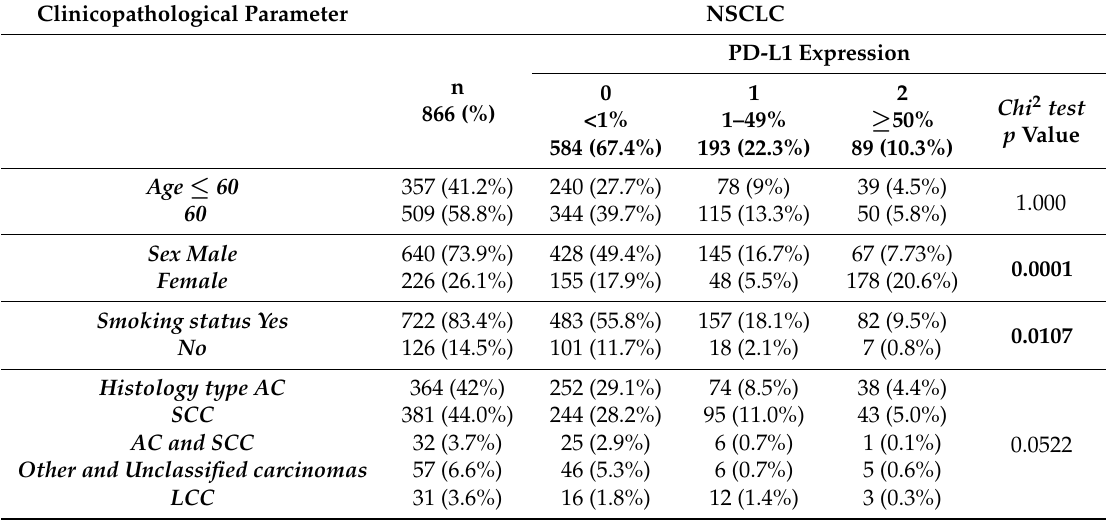
Figure 2. PD-L1 protein expression and CD274 mRNA in non-small cell lung cancer (NSCLC) are higher than in healthy lung tissues. Comparison of PD-L1 protein expression levels detected by immunohistochemistry (IHC) ( A ) in different subtypes of NSCLC (* p = 0.0074). Positive correlation between mRNA expression levels of CD274 detected by the real-time PCR and PD-L1 expression detected by IHC evaluated by Tumor Proportion Score (TPS (0–2) ( B ). Comparison between expression of mRNA CD274 in healthy lung tissues and NSCLC ( C ) adenocarcinoma (AC) ( D ) squamous cell cancer (SCC) ( E ). Table 1. Clinicopathological characteristics of non-small cell lung cancer (NSCLC) patients related to programmed death ligand 1 (PD-L1) expression. Percentages in brackets are relative to the total of 866